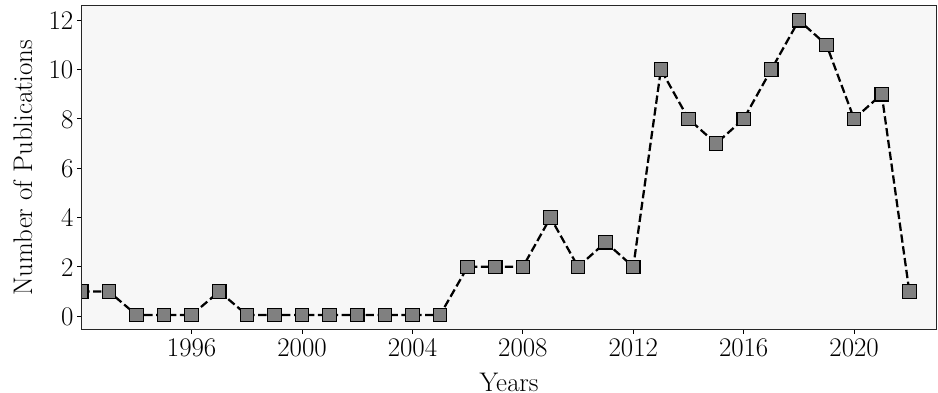
Figure 2. Evolution of number of publications per